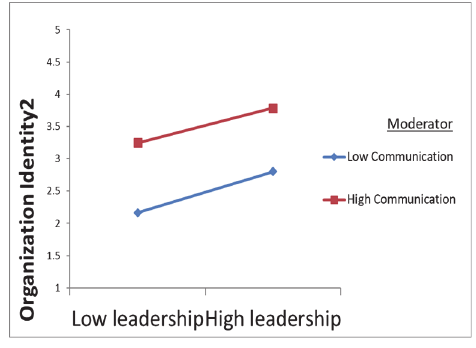
Fig. 2. Interactions between LTWSC and communication on organizational